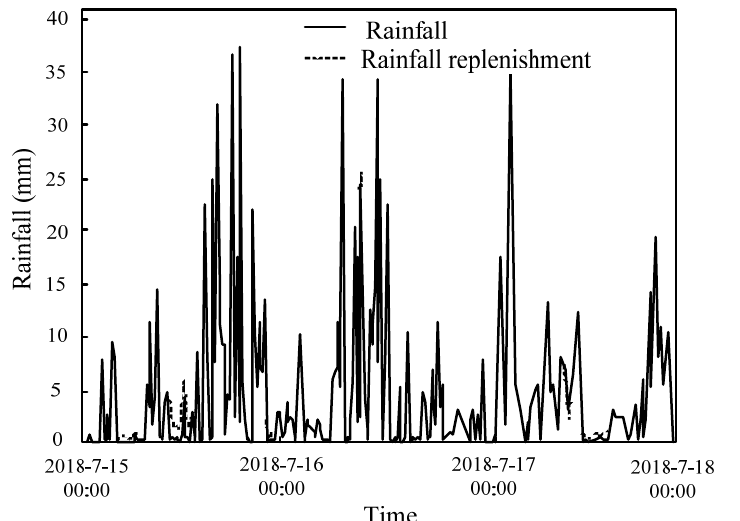
Figure 7. Visualization effect analysis of big data platform.